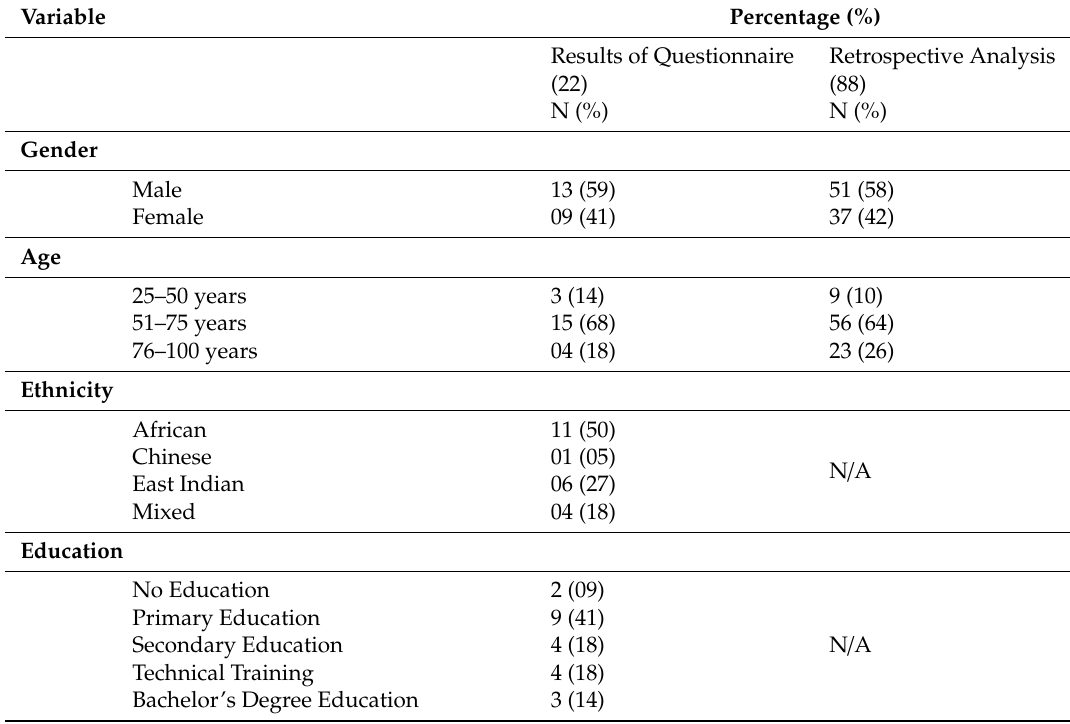
Table 1. Demographics and clinical features of participants and